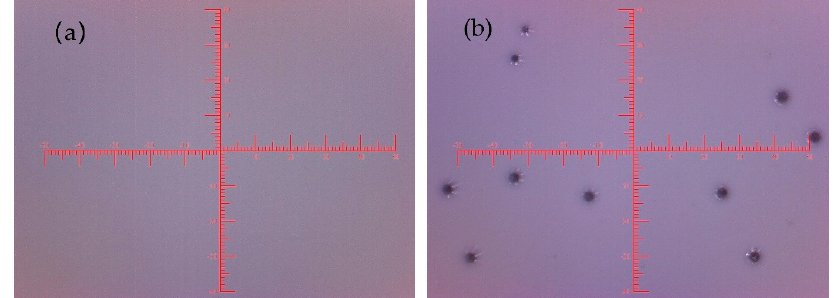
Figure 4. Coating surface under 200× optical microscope. ( a ) 1.0% LDBS added; ( b ) no LDBS added.